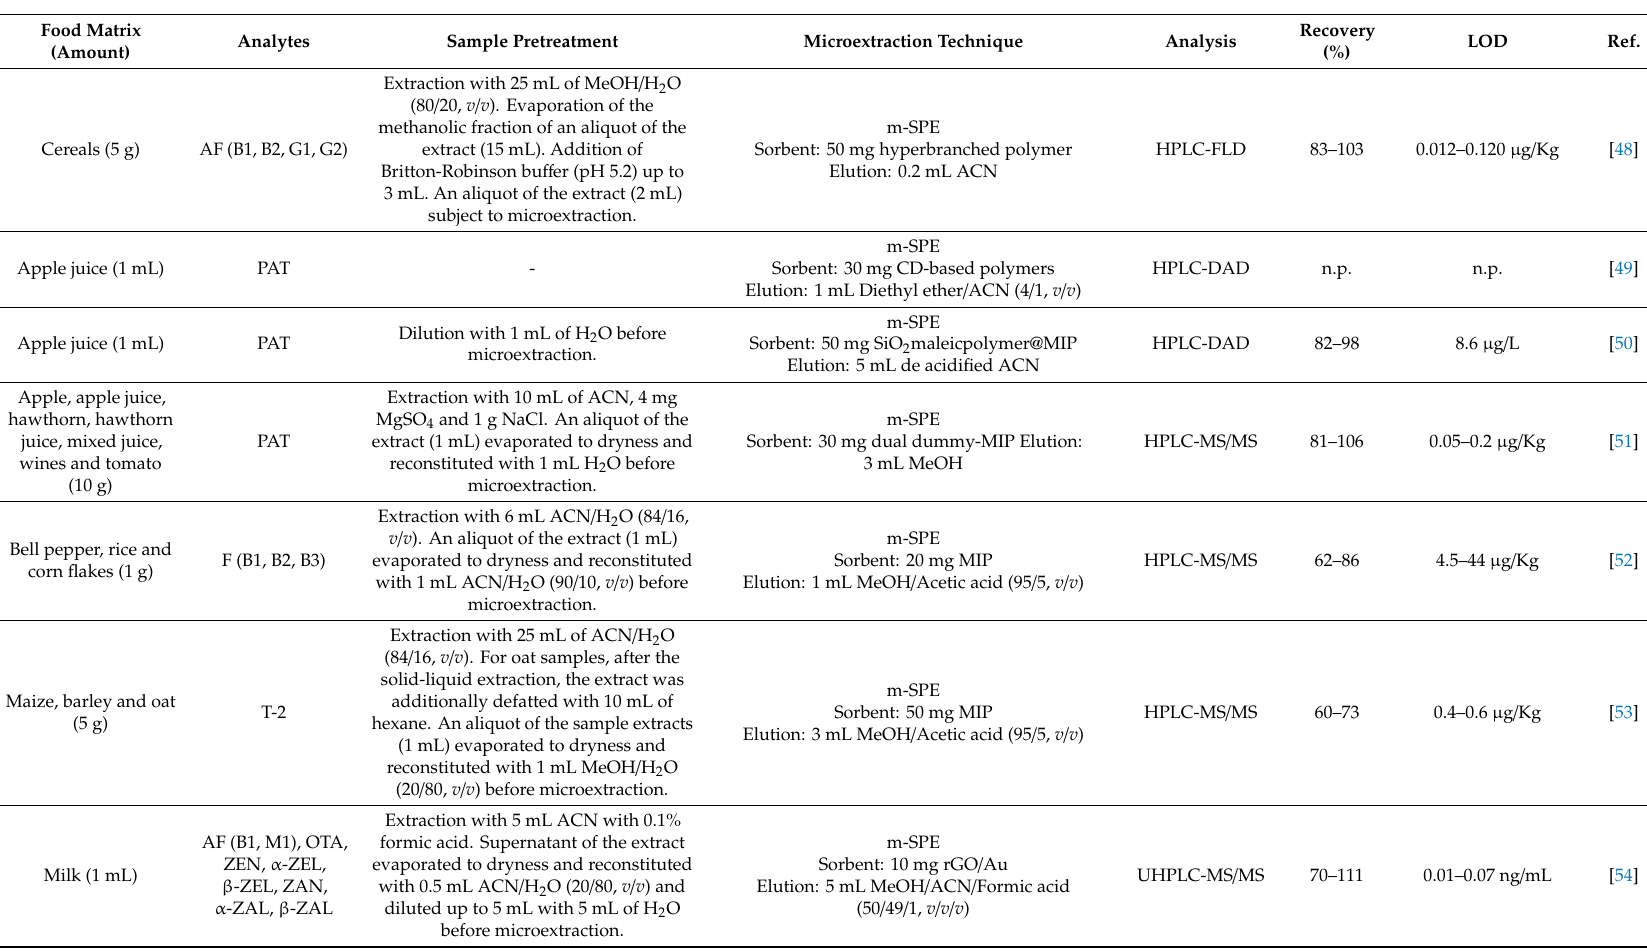
Table 2. Application of new advanced materials on sorbent-based microextraction techniques to isolate natural toxins from food samples (2009–2019). Food Matrix